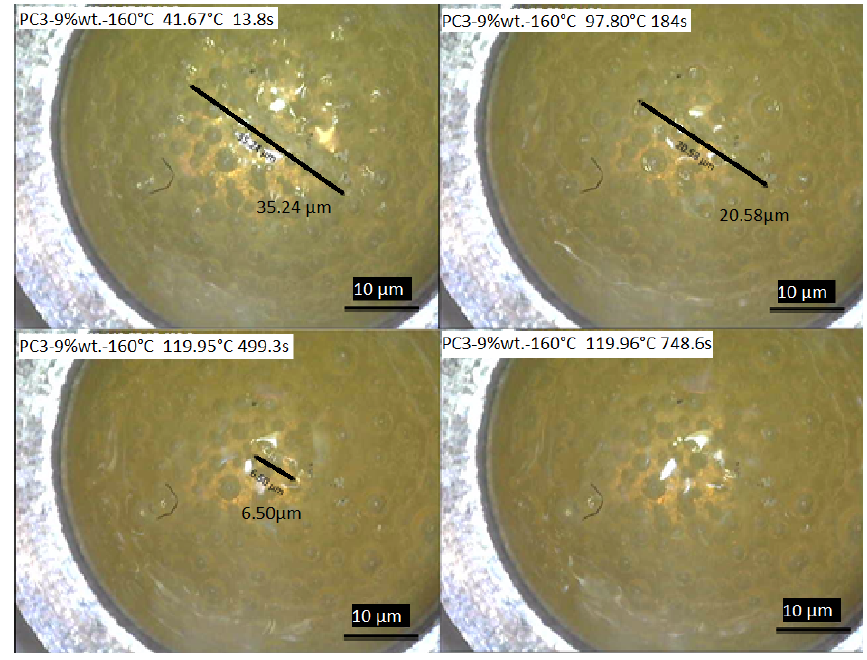
Figure 12. The healing process of the scratch on the film surface of PC3–9% wt.–160 °C recorded during DSC measurements.